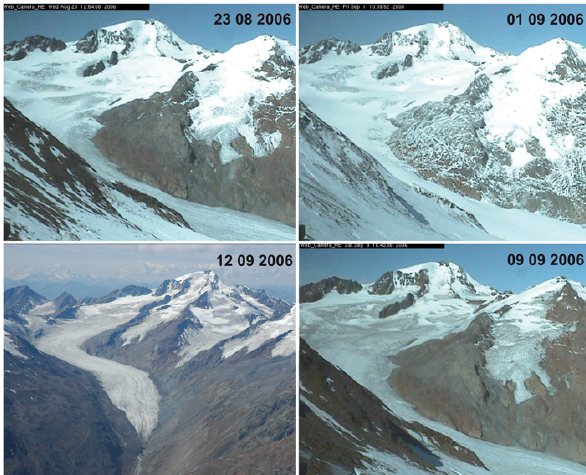
Fig. 12. Snow cover at HEF recorded by web cam images at 23